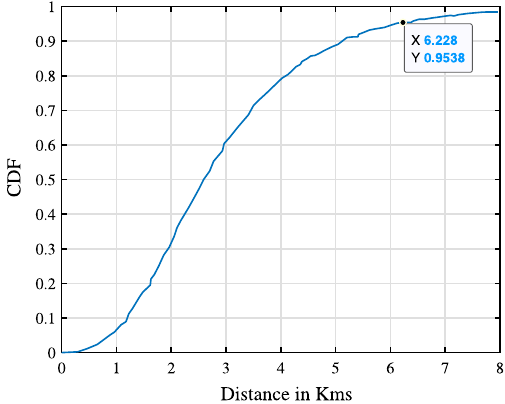
Fig. 1 CDF of maximum distance between a village and a feasible BS in rural Indian